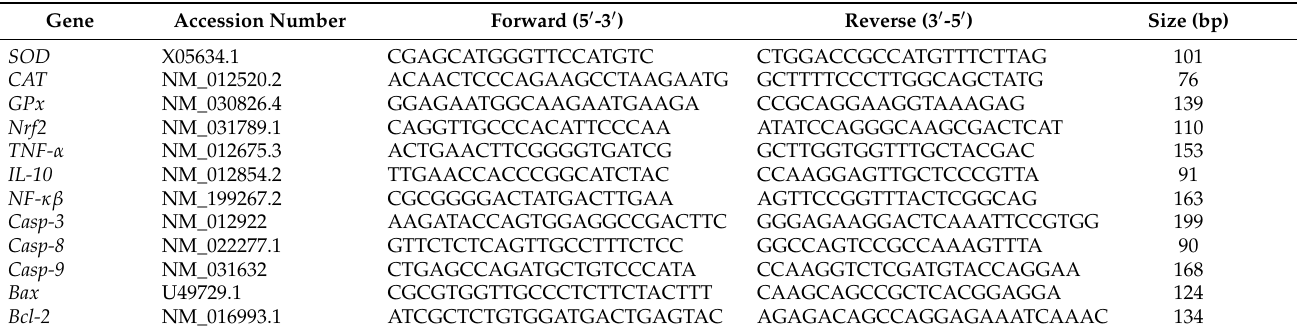
Table 5. List of primer